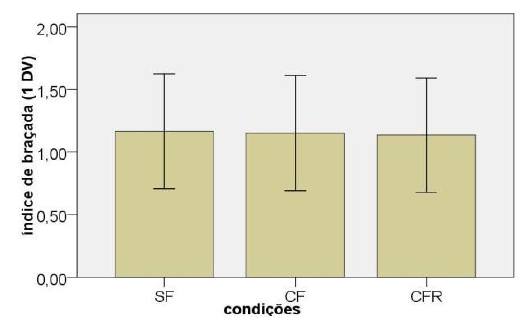
Figura 2. Média e desvio-padrão dos índices de braçadas nas condições de instrução sem foco de atenção (SF), com foco de atenção (CF) e instrução com foco de atenção e redundância (CFR), apenas dos sujeitos que adotaram o foco de atenção solicitado em todas as condições.